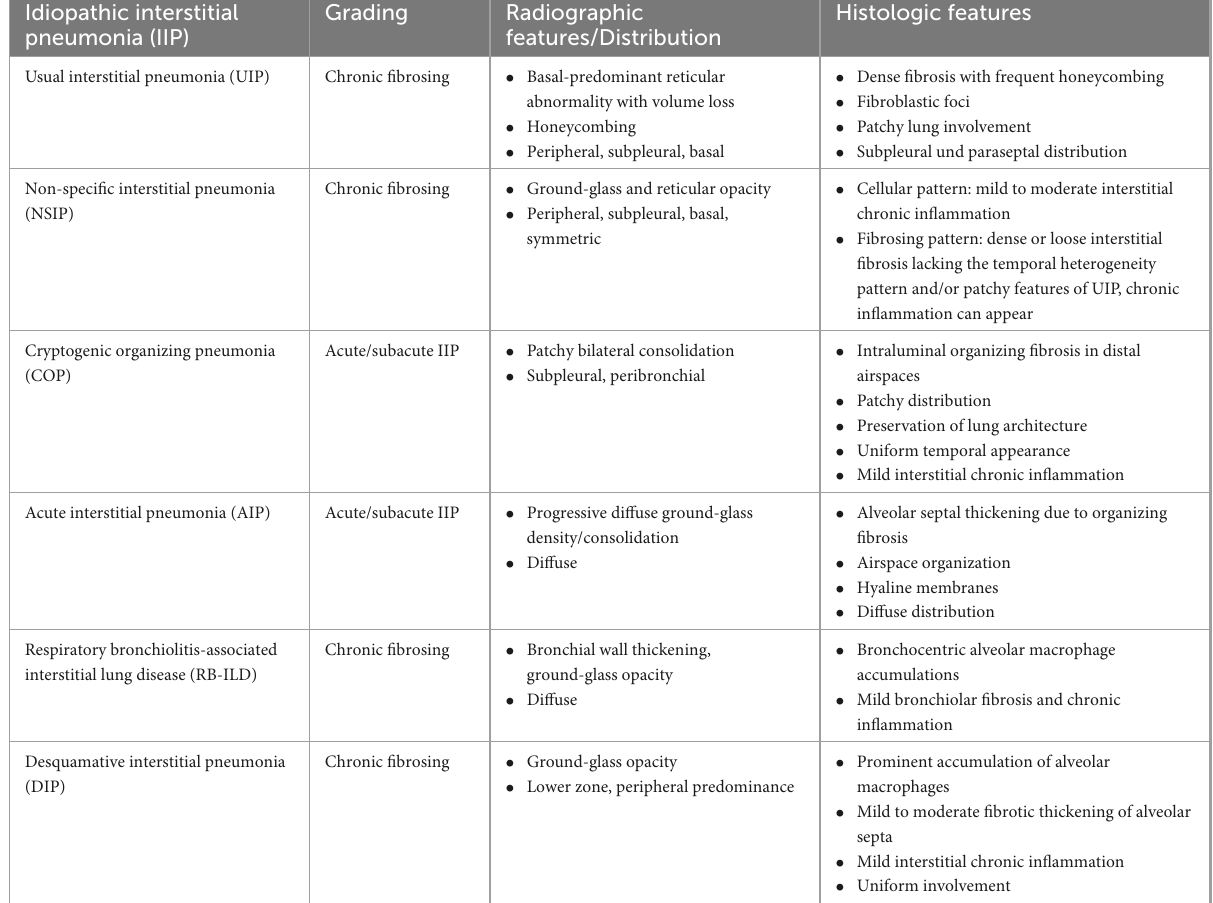
TABLE 3 Radiographic and histologic features of major idiopathic interstitial pneumonias (IIP) according to the classification of the American Thoracic Society (ATS) and European Respiratory Society (ERS) (68, 69). Idiopathic interstitial pneumonia